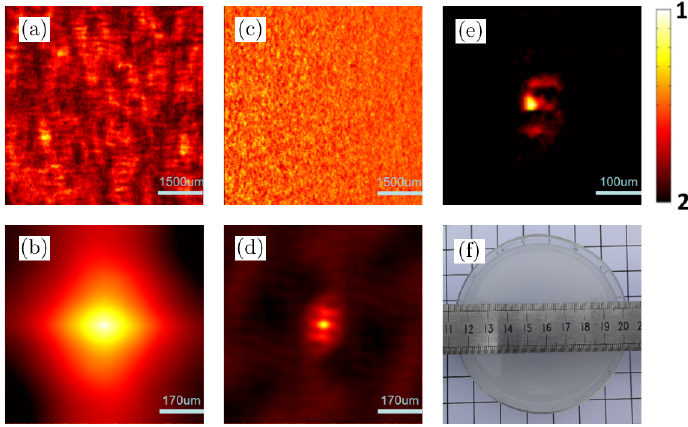
Fig. 6. Experiment result of the tissue-mimicking gelatin layer. (a) is a captured speckle pattern, no image can be acquired from it. (b) is the autocorrelation of (a). (c) The di®erence of two frames (cid:1) I and (d) the corresponding autocorrelation. (e) is the reconstructed image. (f) is a photograph of the tissue-mimicking gelatin